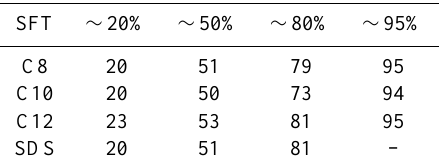
Table 1. Weighed surfactant solute mass-fractions ( W p, SFT [%]) in the atomizer